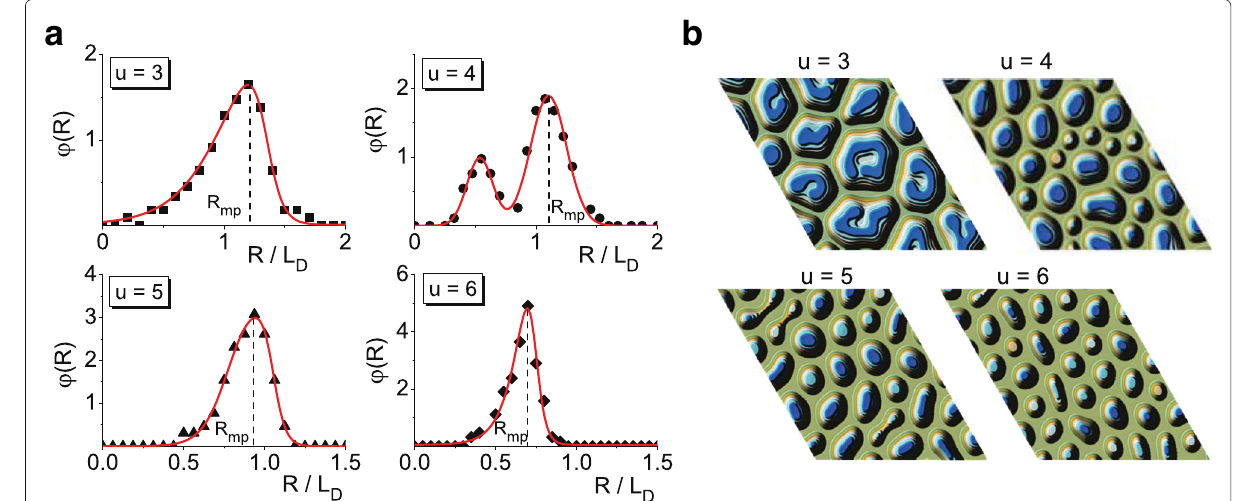
Fig. 5 Distribution functions of adsorbate islands over sizes in stationary limit on a half-height of a growing surface a and typical snapshots of surface patterns b at different values of anisotropy strength u